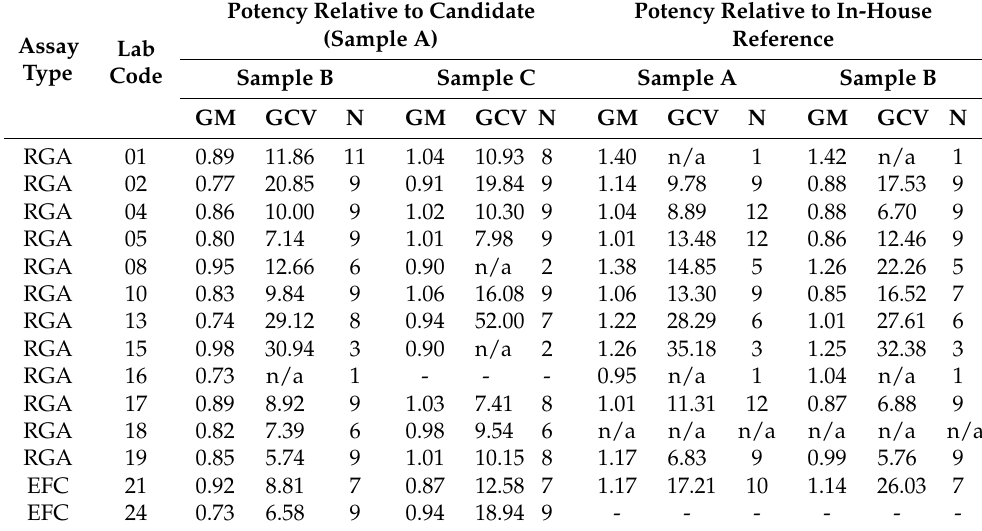
Table 7. Individual laboratory geometric mean relative potency estimates for RGA/EFC assays.